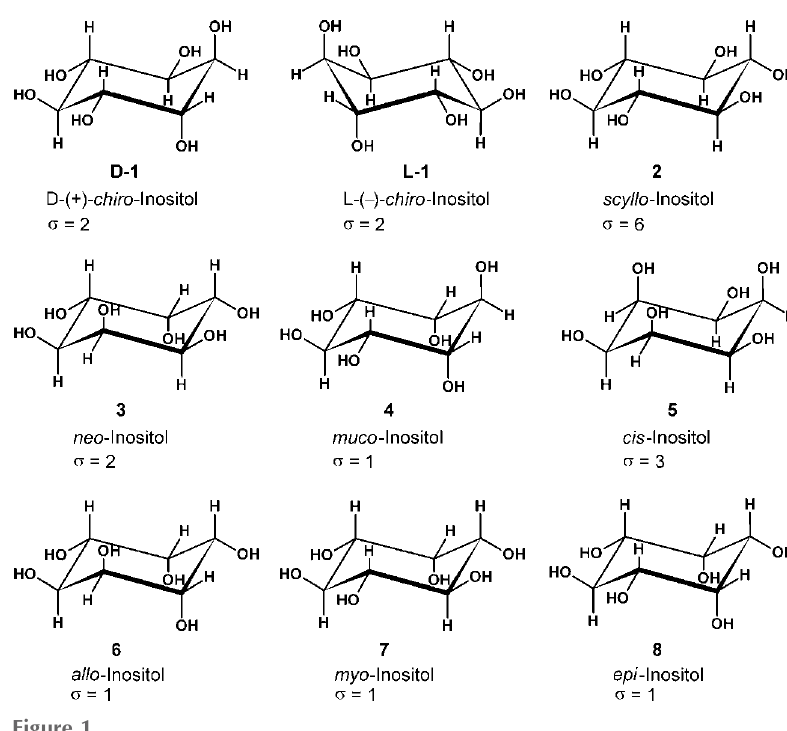
Figure 1 Inositol stereoisomers and molecular symmetry numbers (cid:2)